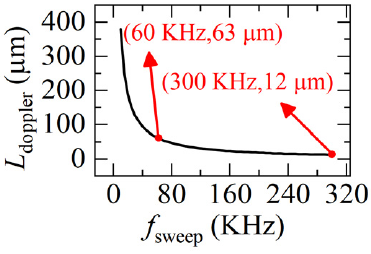
Figure 3. The relationship between the sweeping rate f sweep and the Doppler-induced error L error . ( Δ u = 5.1 × 10 12 Hz, u a = 1.9365 × 10 14 Hz, v = 0.1 m/s, a = 0.1 m/s 2 ).